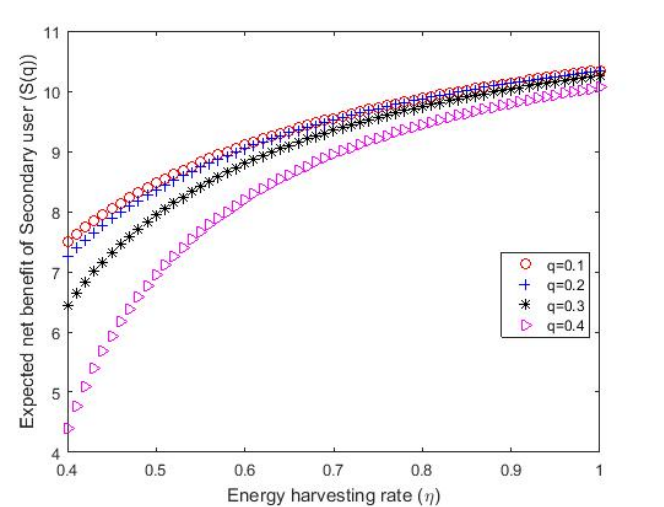
Figure 13. Energy-harvesting rate ( η ) vs. expected net benefit of secondary users.